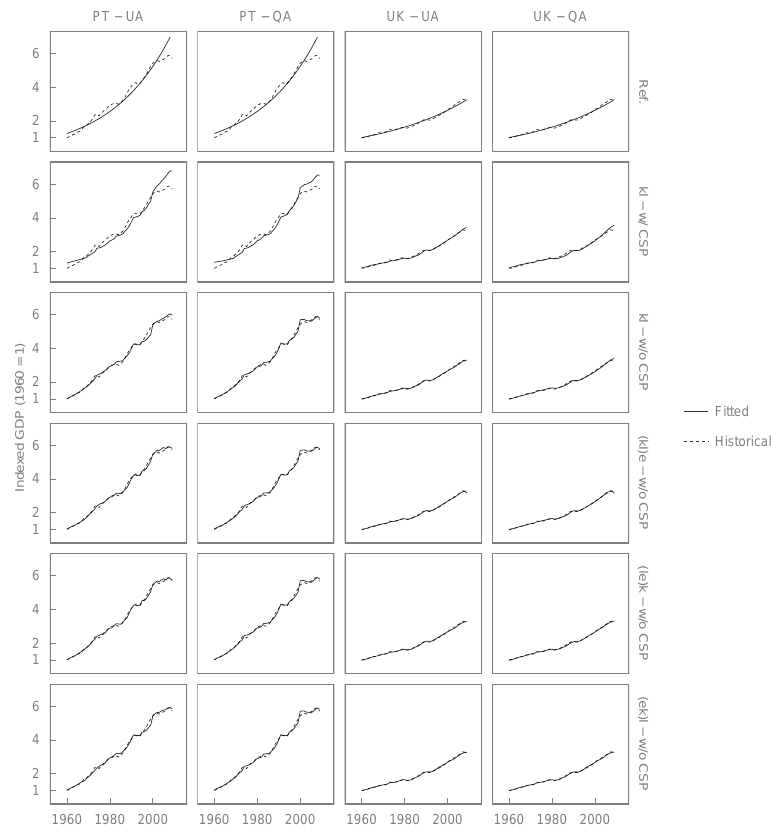
Figure 4. Fitted and historical GDP for all models using unadjusted (UA) and quality-adjusted (QA) data. The solid line gives historical GDP ( y ), and the dashed line shows fitted GDP ( ˆ y